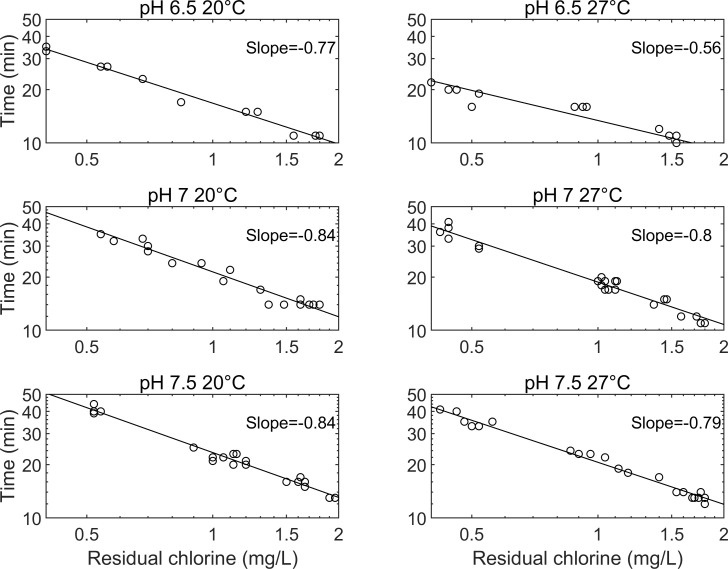
Chlorine residual and time required to achieve a 2.0 ±0.1 log inactivation of S. mansoni cercariae.Results include data for all tested chlorine doses (1,2,3 mg/l).